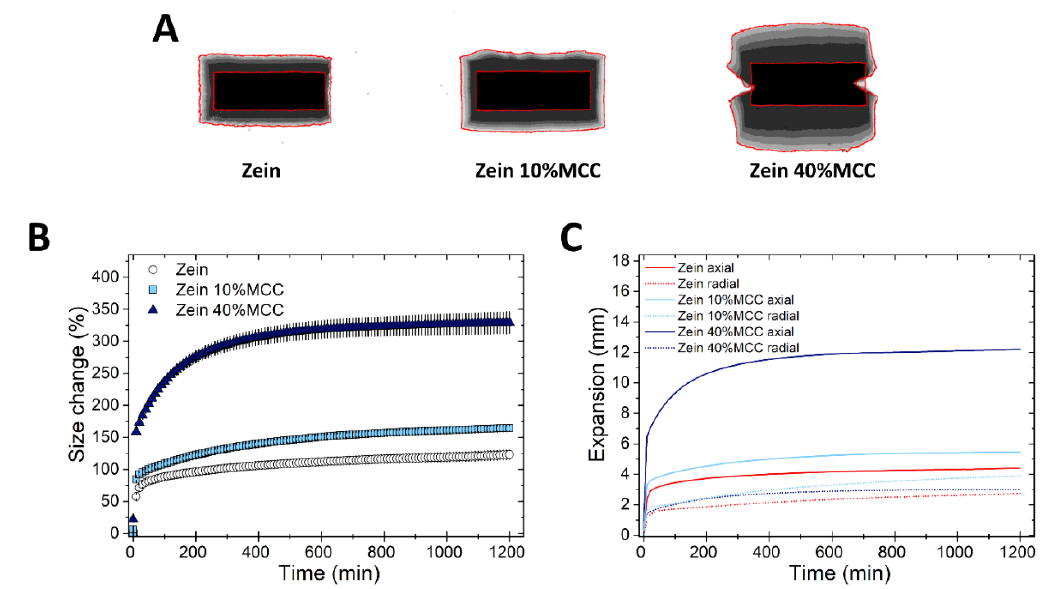
Figure 5. Swelling of tablets made of binary mixtures of zein and MCC (10% and 40% w / w ). ( A ) Sum of Z-stack of images. The two red lines are the outlines of the tablet at time 0 and at 20 h. ( B ) Swelling measured as the change of the projected area of tablets (mean ± SD, n = 3) as a function of time. ( C ) Axial and radial swelling of tablets (mean ± SD, n = 3) as a function of time.